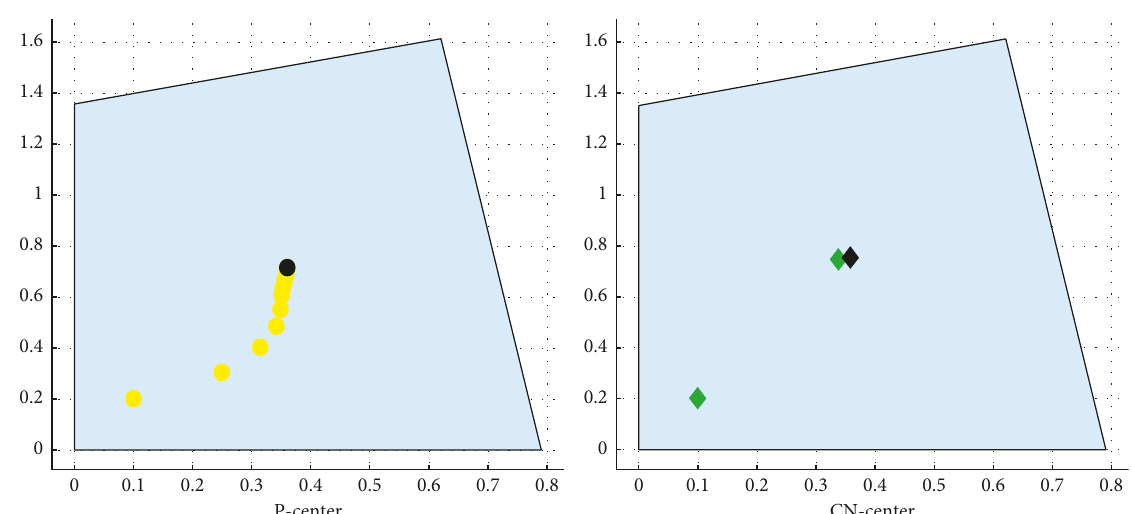
Figure 3: Polytope 3, convergence towards